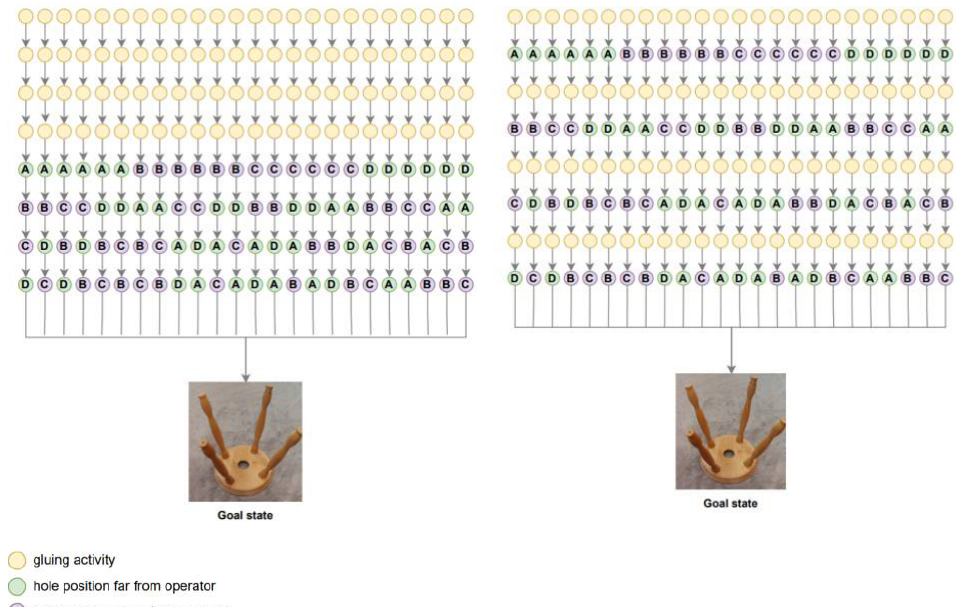
Figure 7. Assembly Intention Scenario.